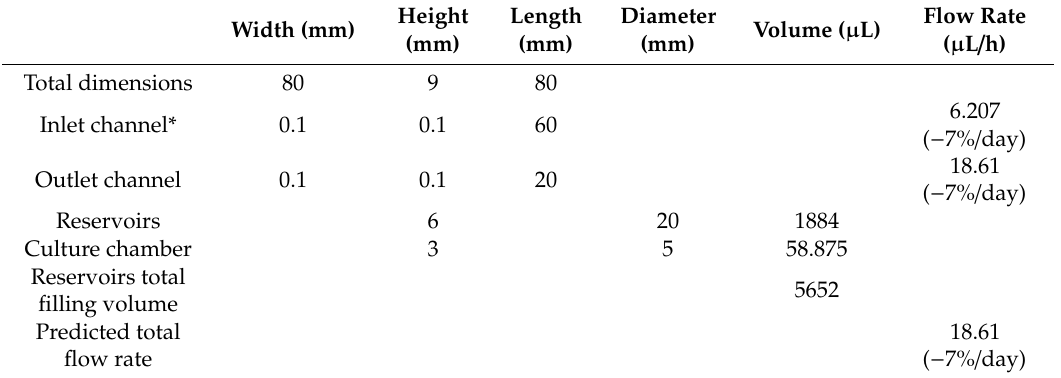
Table 1. Technical data of the microfluidic